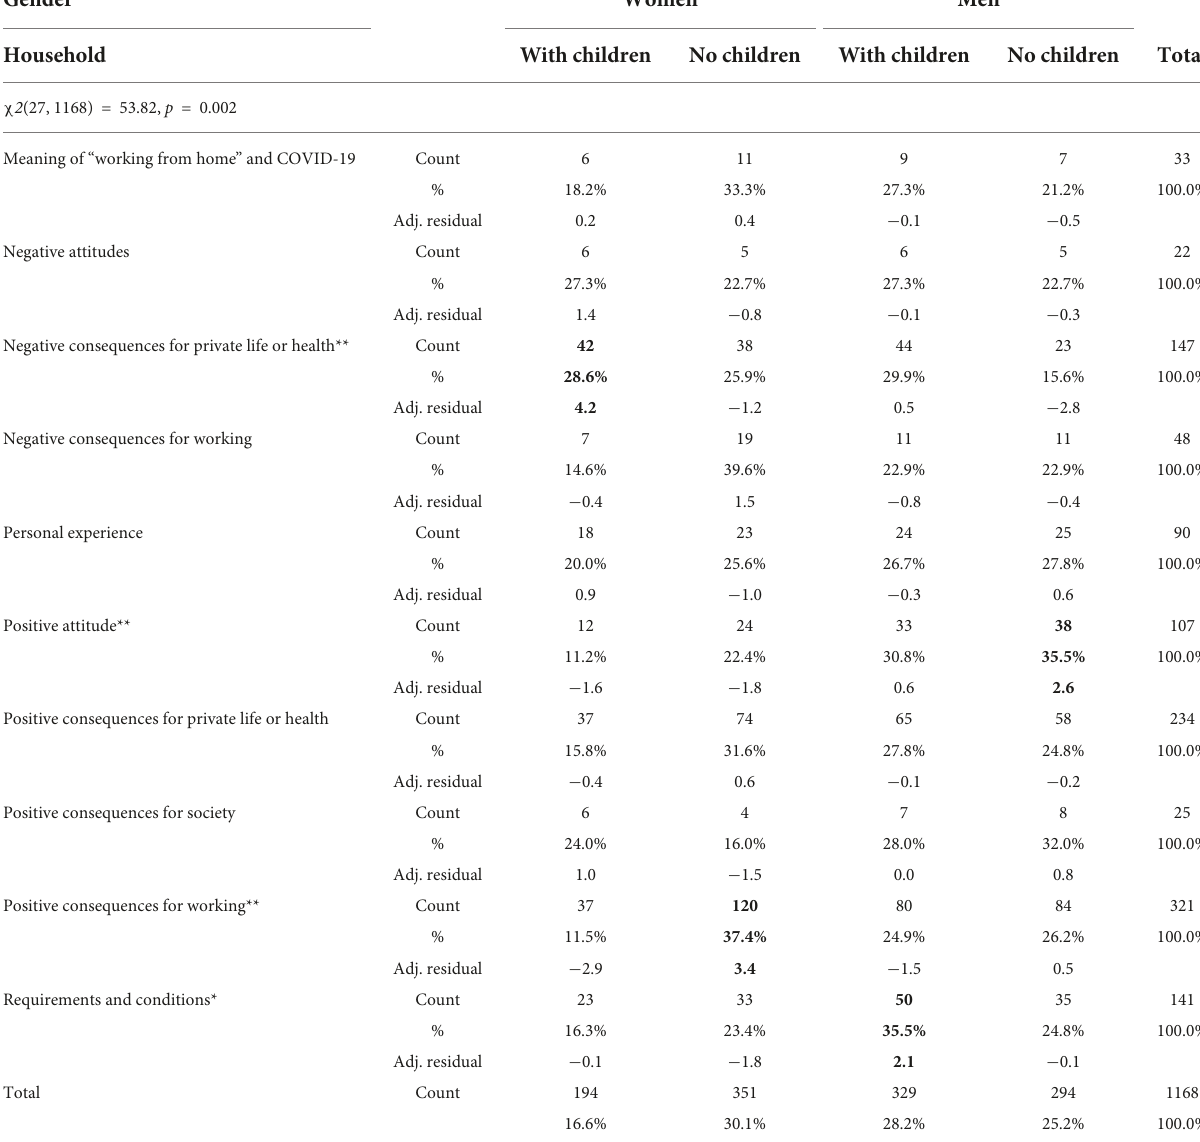
TABLE 2 Contingency table with superordinate